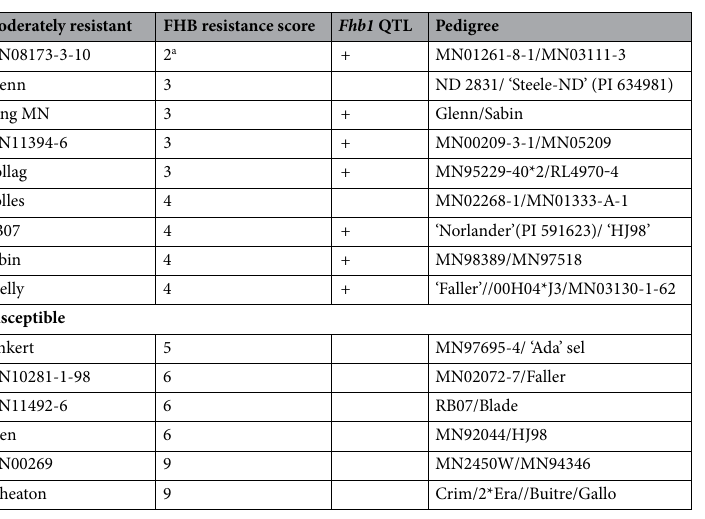
Table 1. Breeding pedigrees for wheat cultivars in the current study. Resistance to Fusarium head blight (FHB) scored on a 1–9 scale (1 fully resistant, 9 highly susceptible), based off of FHB nursery field evaluations. + indicates the presence of the Fhb1 QTL in a cultivar. a Indicates preliminary FHB resistance score; cultivar is currently undergoing multi-year field trials. All cultivars were provided by Dr. James Anderson except for Glenn, which was purchased from a local seed provider. Of the MR cultivars tested two lack Fhb1 , Glenn and Bolles. Unlike the other MR cultivars, Bolles is more distantly related to Sumai 3 (Zhu et al. 24 ; Anderson et al. 27,30 ; Mergoum et al. 31 ), but Bolles’ great-grandparent Nyu Bai is of Japanese origin and has several FHB resistance QTLs that are related to other Chinese sources of resistance like Sumai 3 (McCartney et al. 26 ; Somers et al.